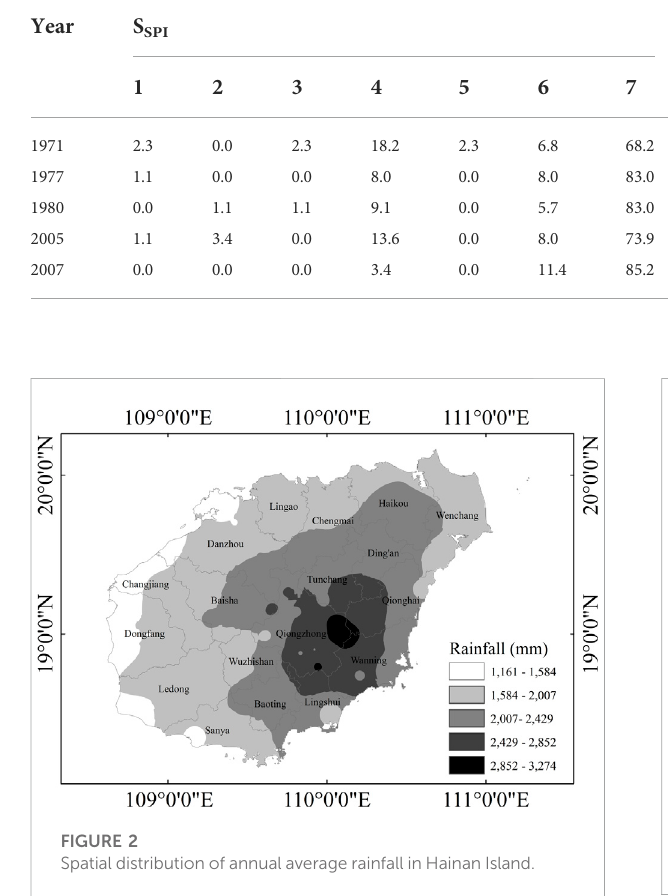
TABLE 4 Comparison of station ratio in extreme drought years in non- fl ood season (%).